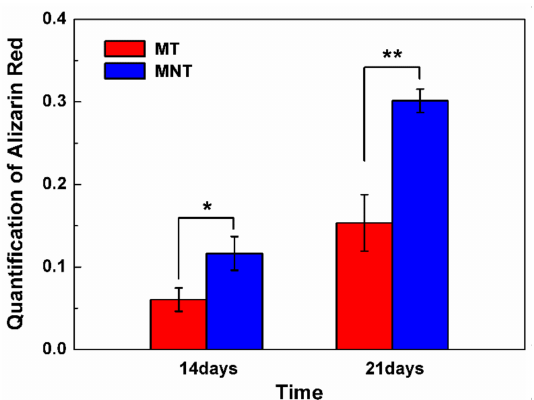
Figure 12. Comparative quantification of alizarin red on the surfaces of MT and MNT coatings after 14 and 21 days. (* represents p < 0.05, ** represents p < 0.01).